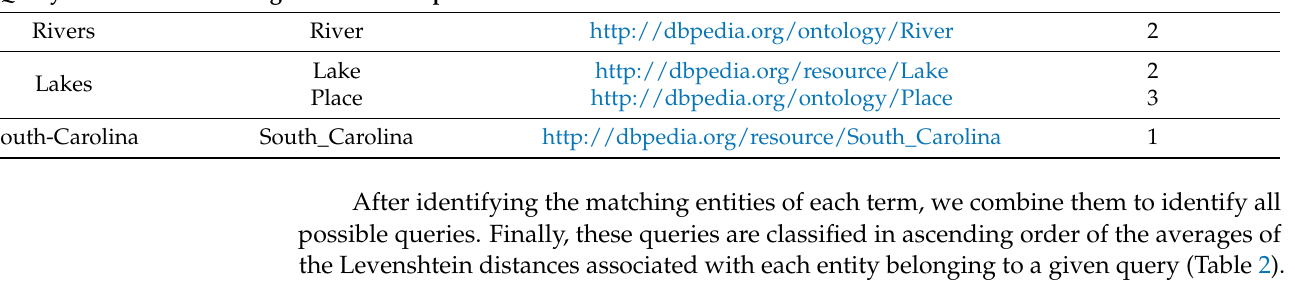
Table 2. Query classification.